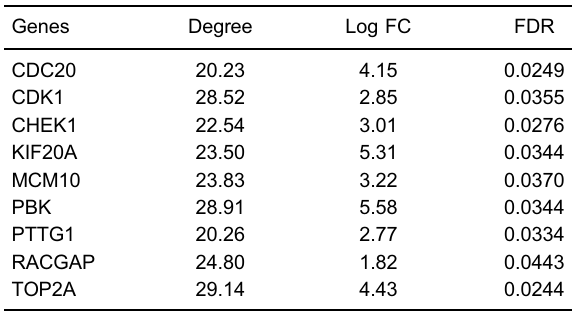
Table 2. Protein-protein interaction network degree and gene expression of identi fi ed hub